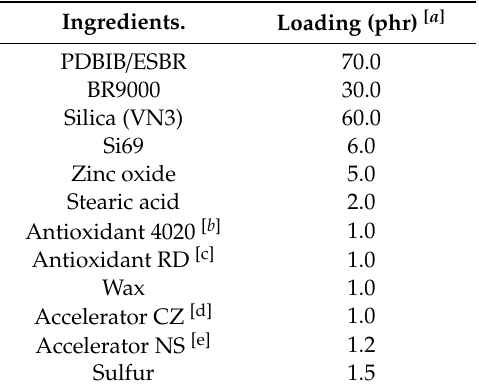
Table 2. Recipe of PDBIB / silica and ESBR / silica nanocomposites. Ingredients.